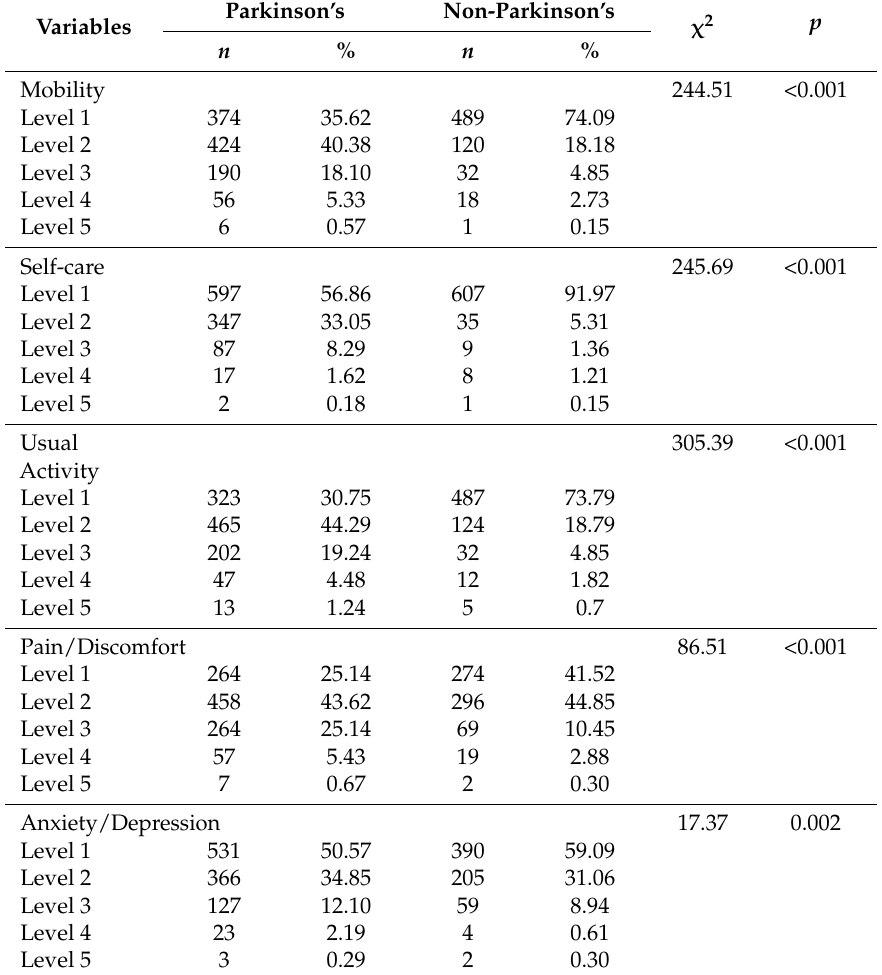
Table 2. The distribution of reported EQ-5D-5L levels 1 to 5 by dimension at baseline ( n = 1710). Parkinson’s Variables